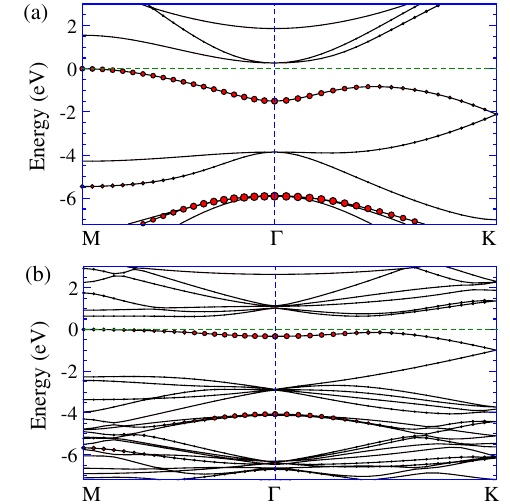
FIG. 4. The LDA band structures for (a) C 3 N and (b) C 12 N . The horizontal green dashed lines denote the VBM levels. The contributions from N p z orbitals to the wave functions are indicated by the radii of the solid